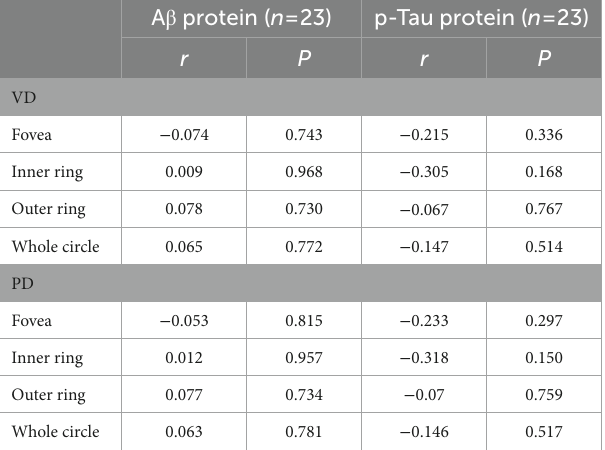
TABLE 6 Correlation between retinal blood flow and A β , p-Tau protein. A β protein ( n = 23) p-Tau protein ( n =